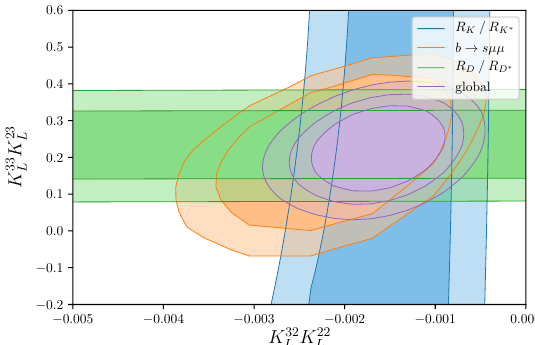
Figure 3 . Likelihood 1 (cid:27) and 2 (cid:27) contours from R global (cid:12)t (1 (cid:27) , 2 (cid:27) and 3 (cid:27) ) in the plane K 33 cf. eq. (2.2). The (cid:12)rst generation lepton and quark couplings are set to zero. (equal to unity when NP decouples, i.e., (cid:20)